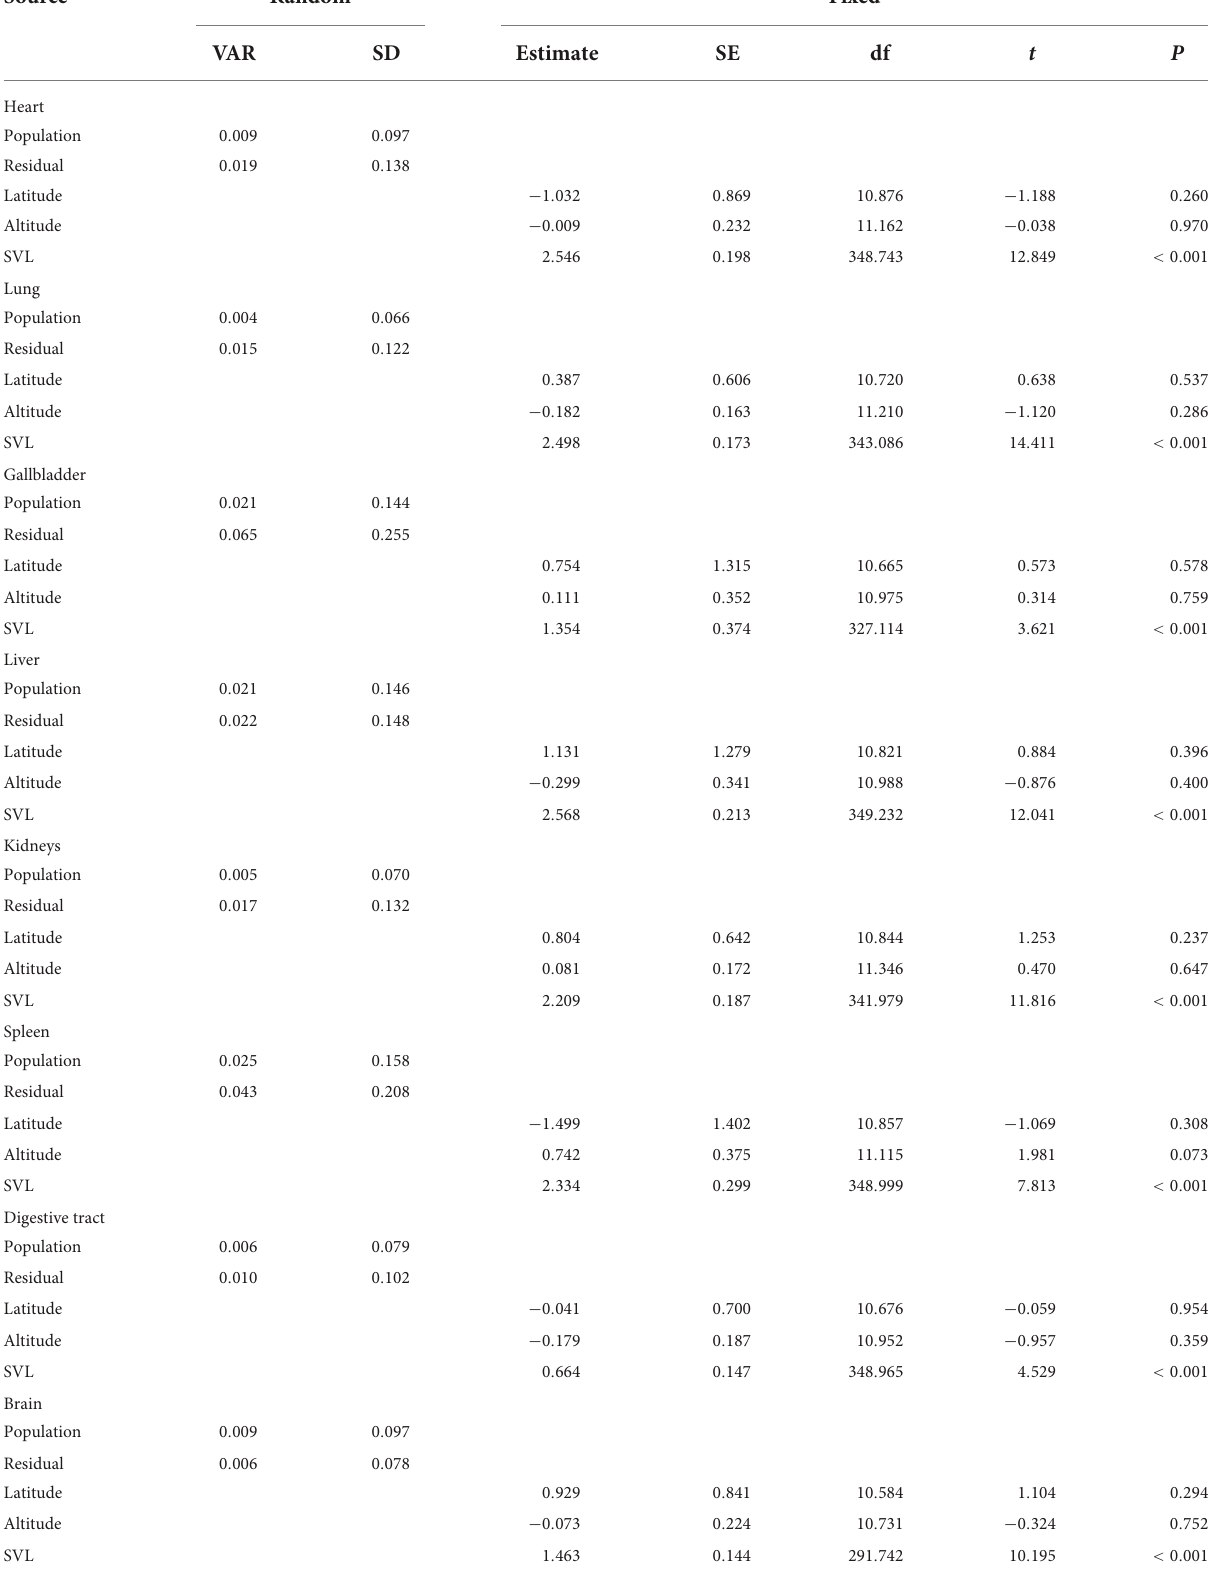
TABLE 2 The effects of altitude, latitude, and population on variation in organ size across 14 populations of the Andrew’s toads when correcting for snout–vent length (SVL) using linear mixed models (LMMs). Source